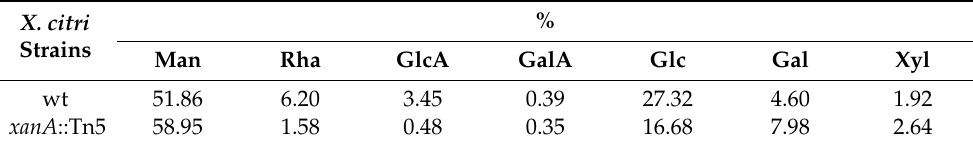
Table 3. Percentages (%) of monosaccharides present in the xanthan gum produced by Xanthomonas citri subsp. citri strains.